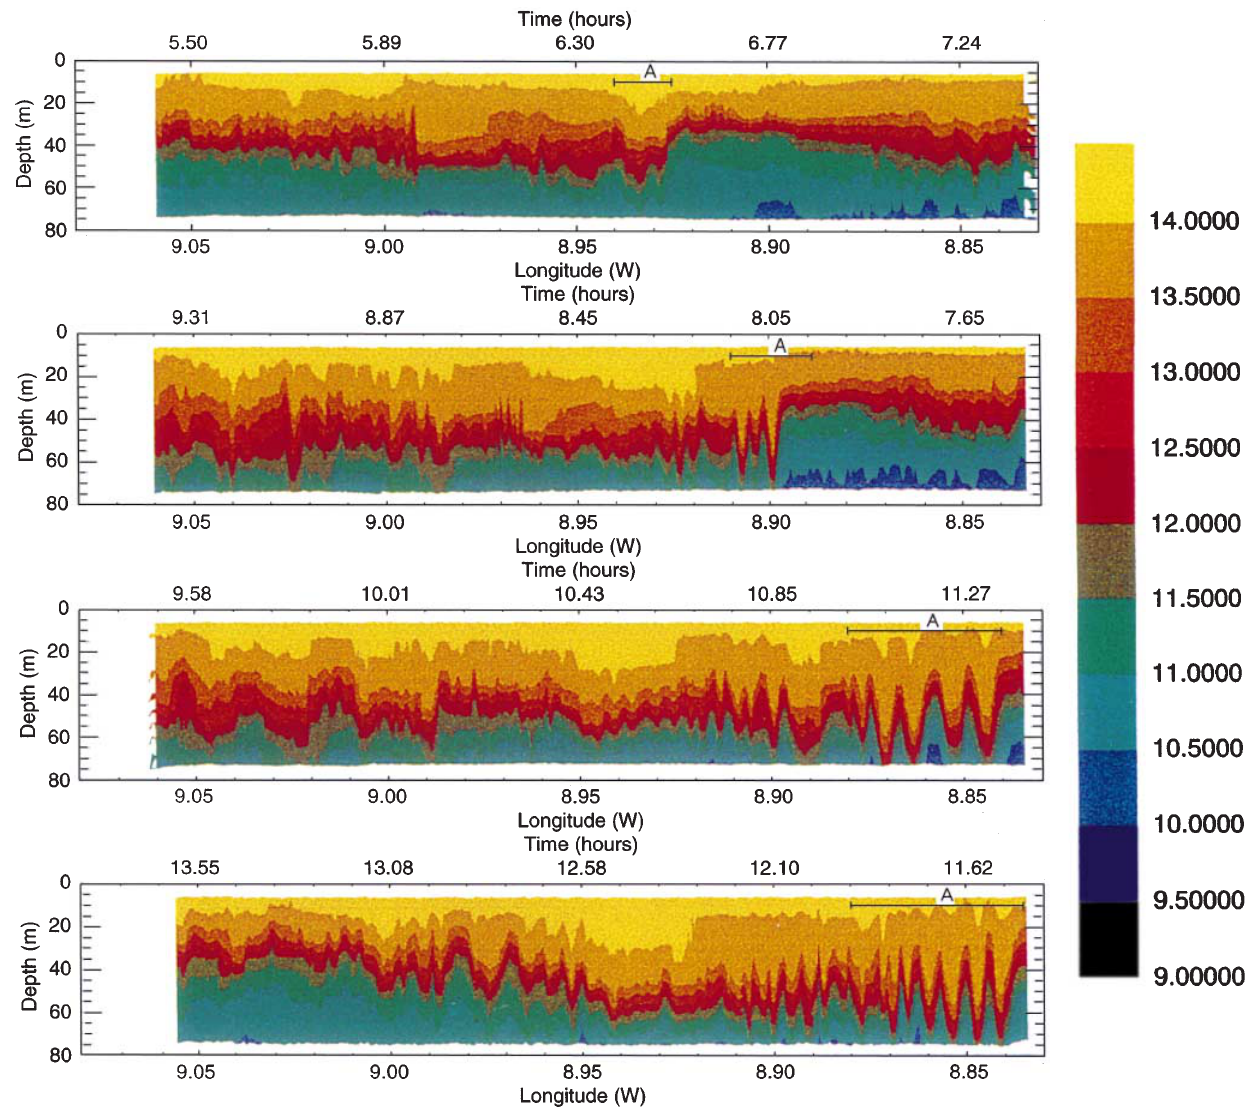
Fig. 2. Contours of temperature in (cid:176) C from the thermistor chain for four consecutive surveys across the Malin shelf-edge. Longitude position is marked at the bottom of each plot, time at the